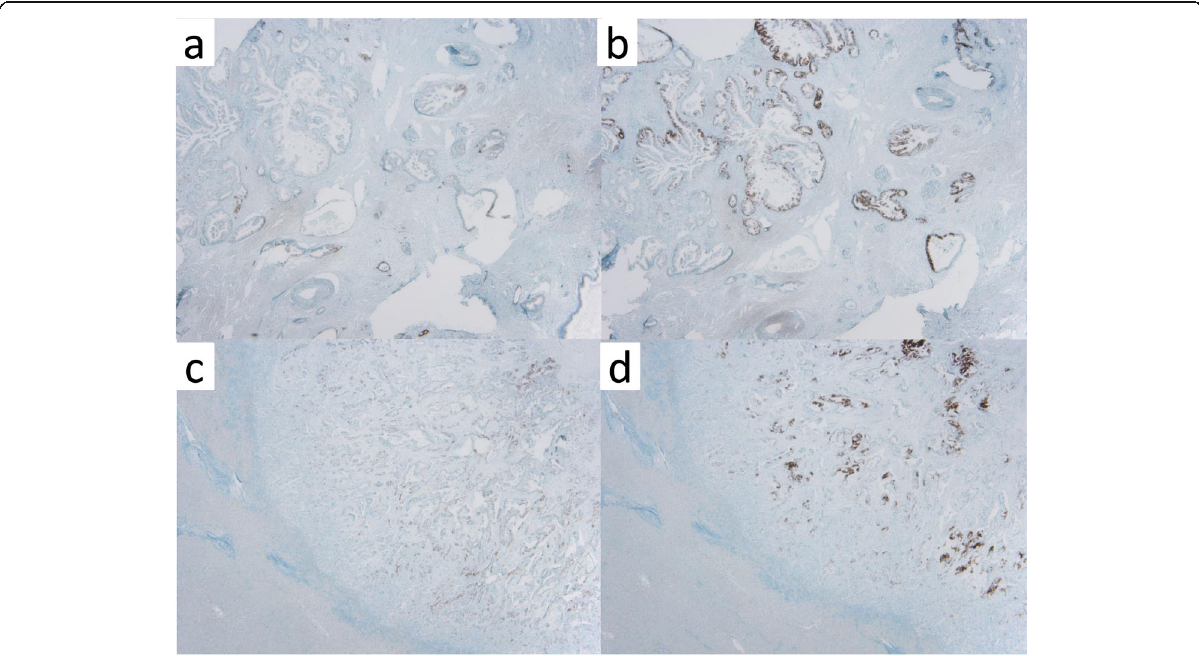
Fig. 7 Histopathological findings (immunostaining × 4 original magnification) showing positive cytokeratin 17 and MUC5AC results in the primary lesion ( a , b ) and metastatic lesion ( c , d